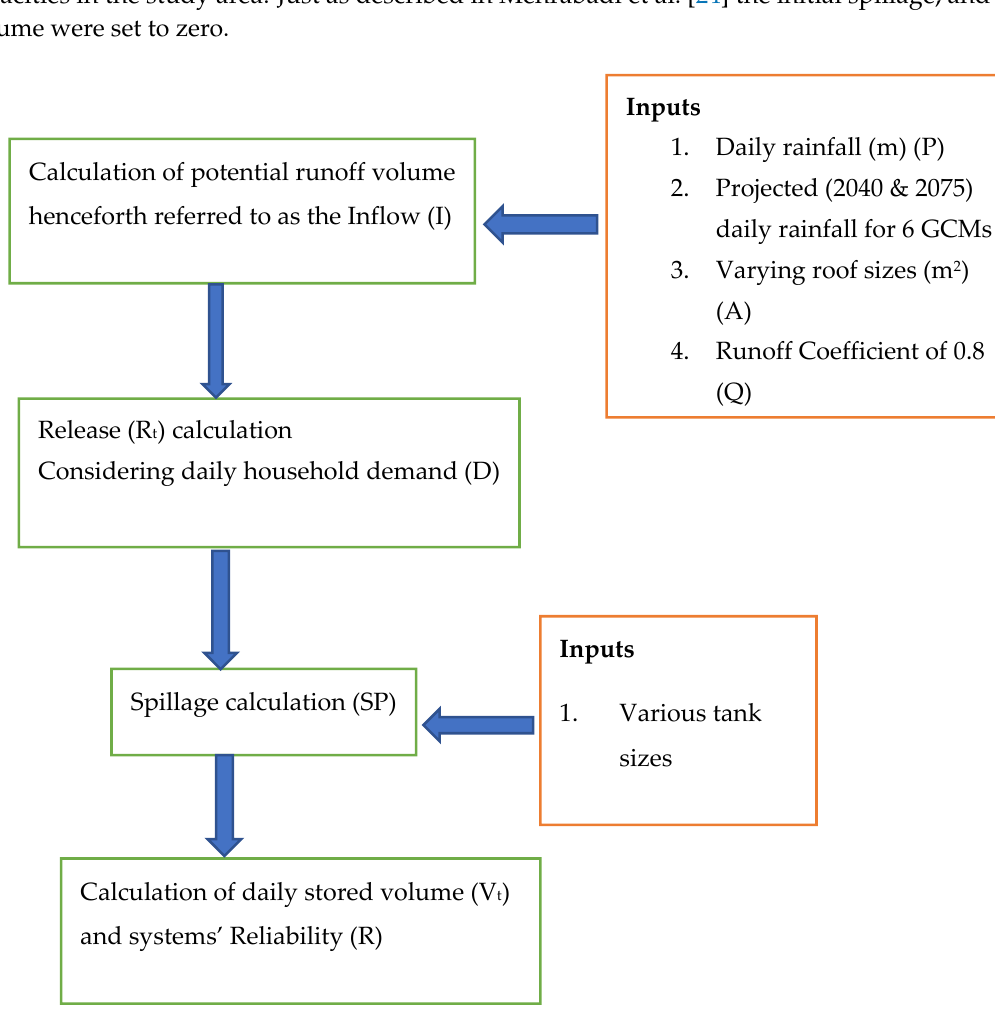
Figure 3: Summary of steps taken in estimation of reliability of rainwater harvesting systems with climate change and varying design combinations